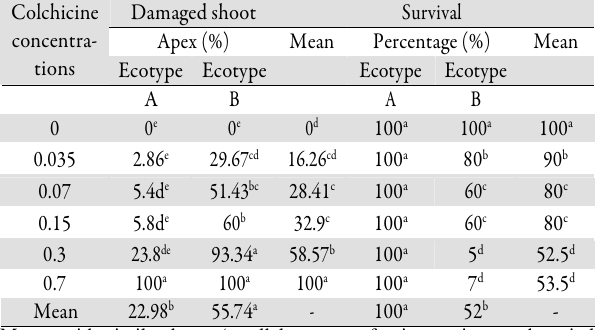
Tab. 3. The survival rate and damaged shoot apex of two Iranian mint ecotypes ( Mentha mozaffarianii Jamzad.) under affecting of apical meristem, colchicine treatments